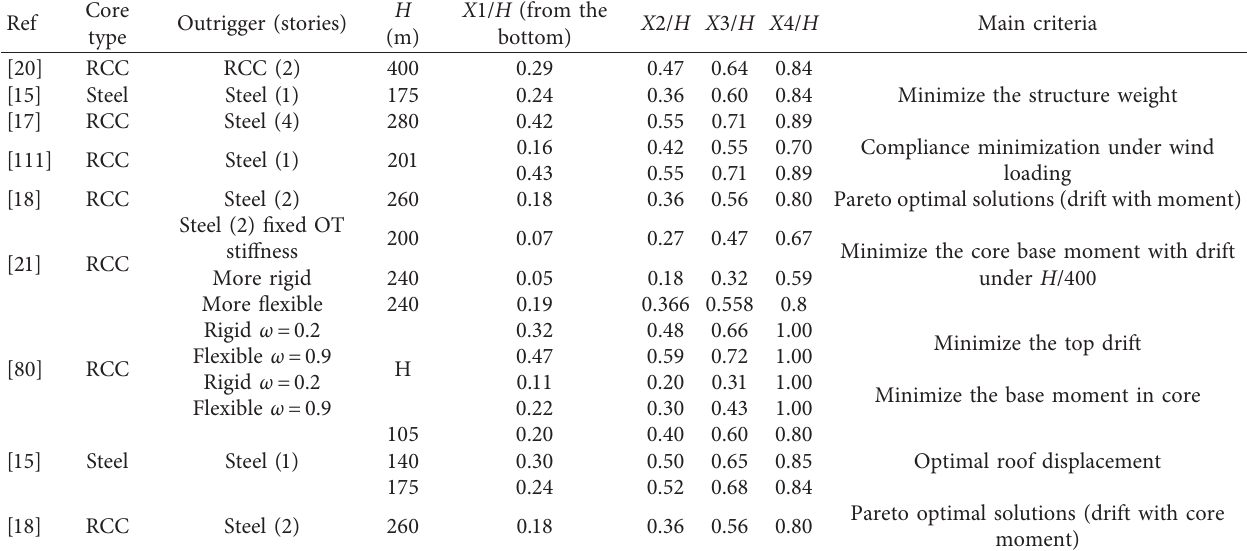
Table 8: Four outrigger structures.